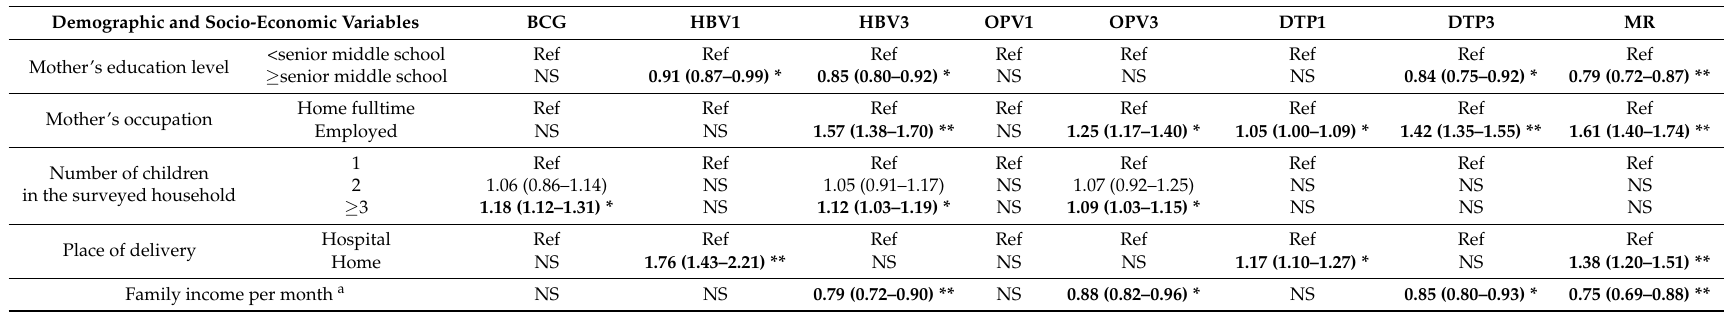
Table 4. Hazard ratio (with 95% CI) for untimely immunization of eight different vaccine doses among children aged 24–36 months, in Zhejiang province (Cox proportional hazard regression, final models, N =